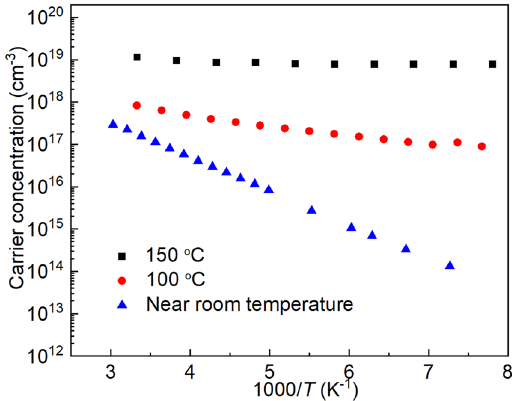
Figure 1: Temperature dependence of carrier concentration of Zn 3 N 2 thin fi lms grown at di ff erent temperatures ( near room temperature, 100 and 150°C ) ( reprinted from ref. [ 31 ]) .